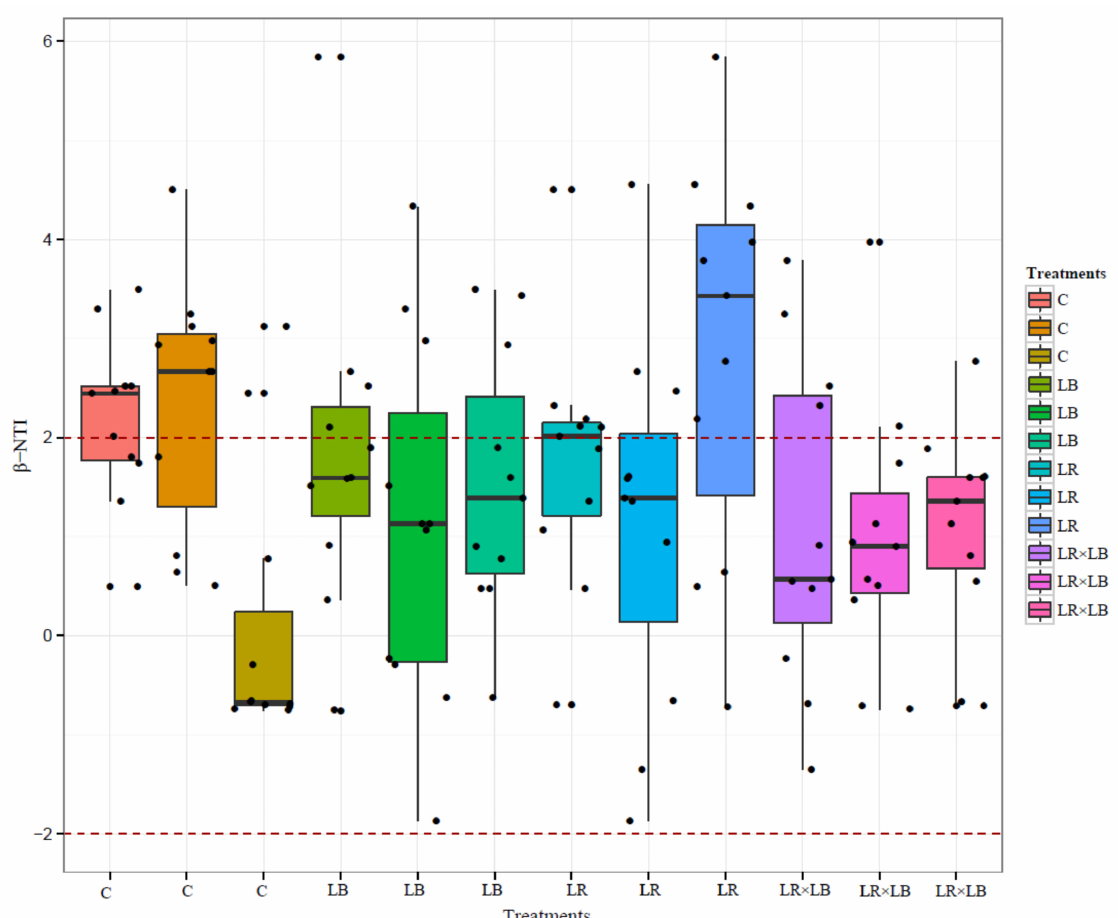
Figure 5. β -NTI of paper mulberry silage. C: silage with distilled water; LB: silage with LB-TSy; LR: silage with LR-BDy; LR × LB: silage with LB-TSy and LR-BDy. The microbial Spearman correlation coefficient at the genus level is presented in Figure 6a. The microbial abundance of Lactobacillus was the highest, which was negatively correlated with Staphylococcus and Enterobacter and repressed the growth of other microor- ganisms. The microbial Spearman correlation coefficient at the species level is displayed in Figure 6b. L. pentosus , L. rhamnosus , L. buchneri , and Weissella cibaria were the most abun- dant. L. pentosus was negatively correlated with L. odoratitofui and positively correlated with Weissella paramesenteroides . L. rhamnosus was positively correlated with Acetobacter fabarum and Pantoea agglomerans and negatively correlated with Serratia rubidaea . L. buchneri had a positive correlation with the family Rhodothermaceae and negative correlation with Serratia rubidaea and Bacteroides_acidifaciens . Weissella cibaria was positively associated with Lactobacillus manihotivorans and negatively associated with Sphingomonas roseiflava and Enterobacter mori